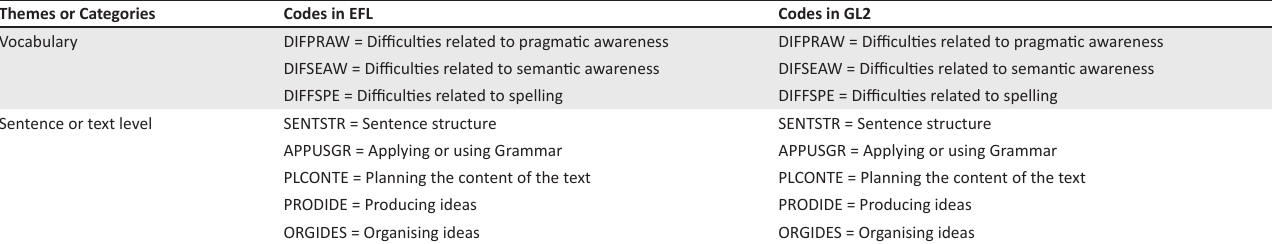
TABLE 5: Categories and codes of the thematic strand ‘writing